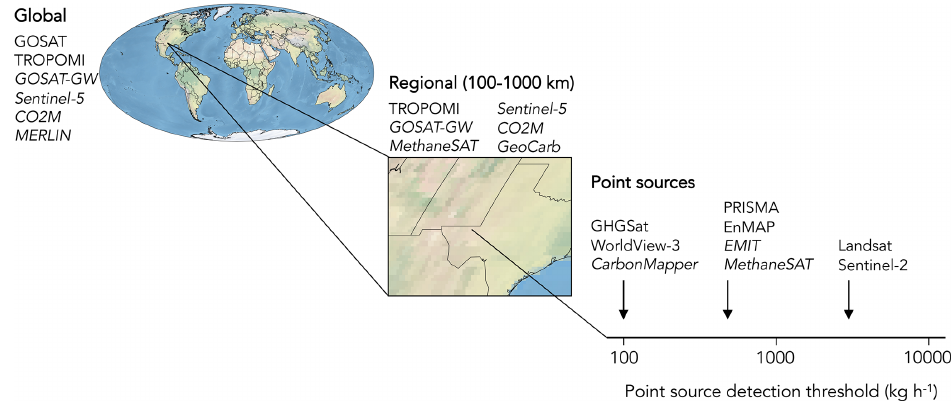
Figure 4. Classification of satellite instruments by their capability to observe atmospheric methane on global scales, on regional scales with high resolution, and for point sources. Specifications for the satellite instruments are listed in Table 1, and key attributes are listed in Table 2. Point source detection thresholds are given here as orders of magnitude. These detection thresholds are discussed in Sect. 5.2. Instruments not yet launched are in